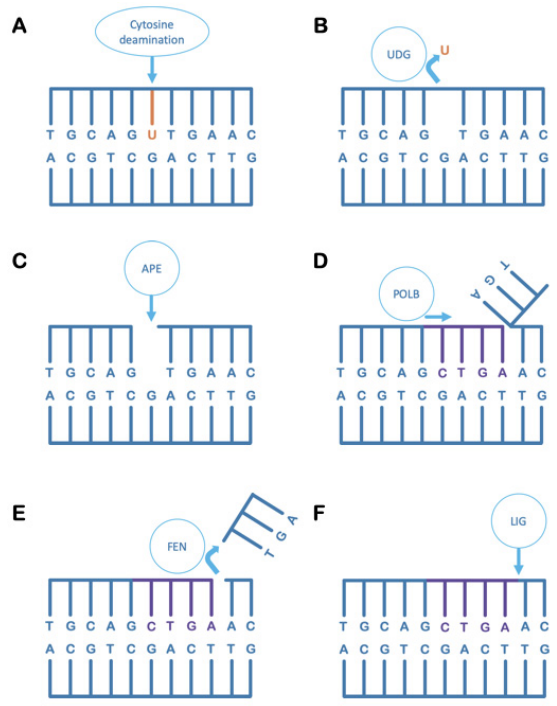
Figure 2. The base excision repair pathway. ( A ) Uracil spontaneously occurs in DNA due to the deamination of cytosine bases. If left uncorrected, the uracil-containing strand will give rise to a permanently mutated daughter strand upon replication. ( B ) A uracil-DNA glycosylase (UDG) cleaves the uracil base from the DNA backbone, leaving an abasic site in the DNA. ( C ) An AP-endonuclease (APE) cleaves the phosphodiester backbone, 5 ′ of an abasic site [AP refers to apyrimidinic, or lacking a pyrimidine; it can also refer to apurinic in other contexts]. ( D ) A type-B DNA polymerase (POLB), typically involved in short-patch DNA repair, resynthesises several bases complementary to the undamaged strand while displacing the cleaved strand beginning at the nick generated by AP-endonuclease. ( E ) A Flap-Endonuclease (FEN) cleaves off the displaced DNA strand after the B-type DNA polymerase has dissociated, leaving behind a nick in the DNA duplex. ( F ) A DNA ligase (LIG) seals the nick to return DNA to its canonical pre-damaged state.